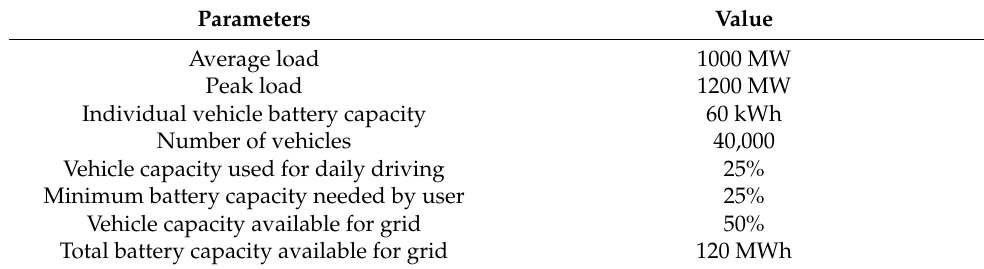
Table 3. Parameters used for calculating the impact on the